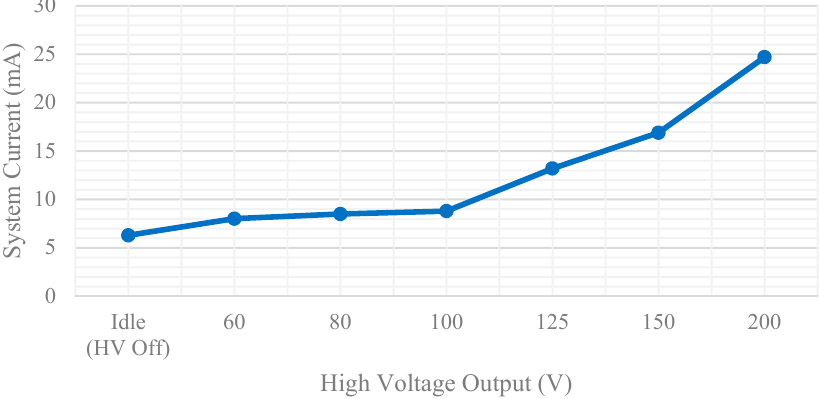
Figure 14. High voltage SMPS power on/off waveforms.